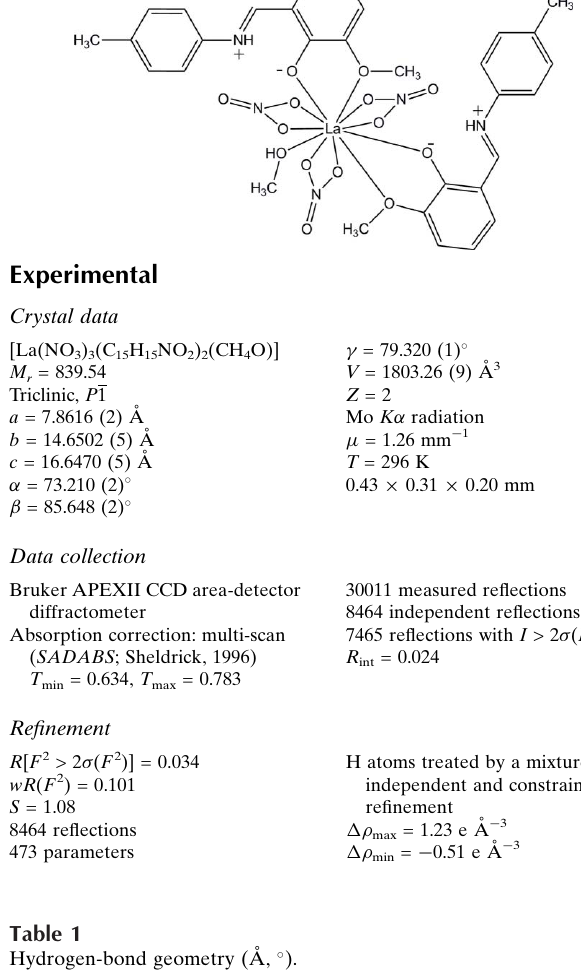
Hydrogen-bond geometry (A˚ , (cid:3) ). D —H (cid:2)(cid:2)(cid:2) A D —H